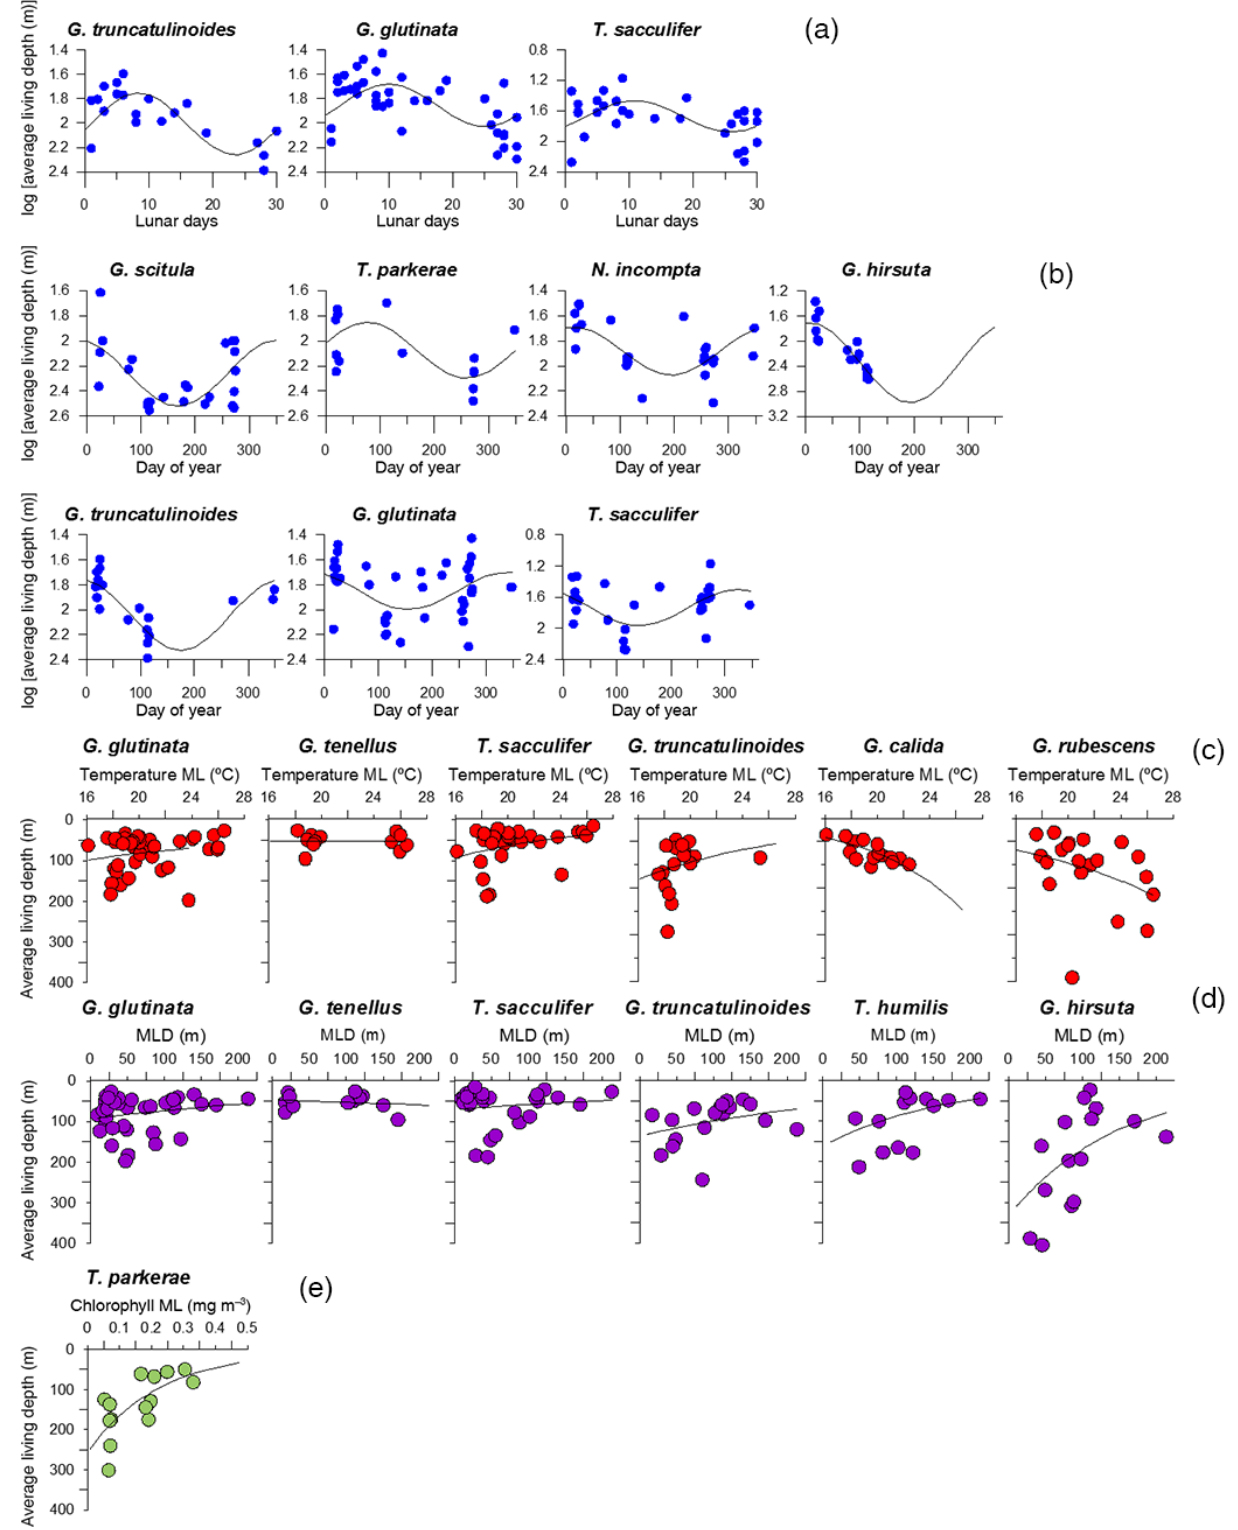
Figure 9. Comparison of modeled and observed ALD in species where ALD appears to be predictable ( p <0.05, Table 3) by (a) lunar cycle, (b) yearly cycle, (c) mean temperature in the mixed layer interval, (d) mixed layer depth and (e) mean chlorophyll a concentration in the mixed layer